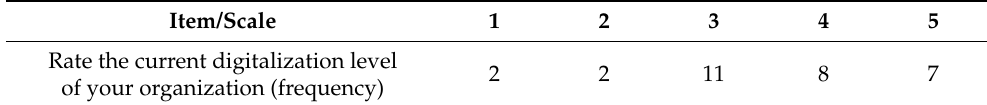
Table 5. Current digitalization level